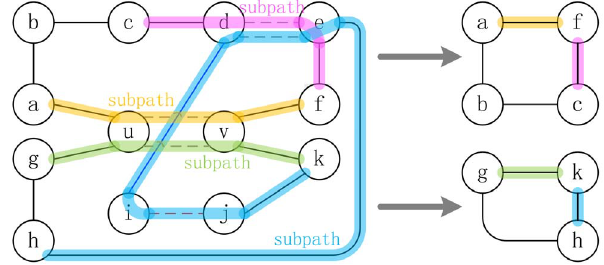
Figure 2. Transforming paths to black cycles. Vertices u, v are matched. The upper path is (u, a, b, c, d, e, f, v), and the bottom path is (u, g, h, e, d, i, j, k, v). Four colored subpaths on the left are contracted into four edges in the right cycles, respectively. An odd path is transformed into an even cycle, while an even path is transformed into an odd cycle. Solid and dashed edges correspond to black and gray edges, respectively.